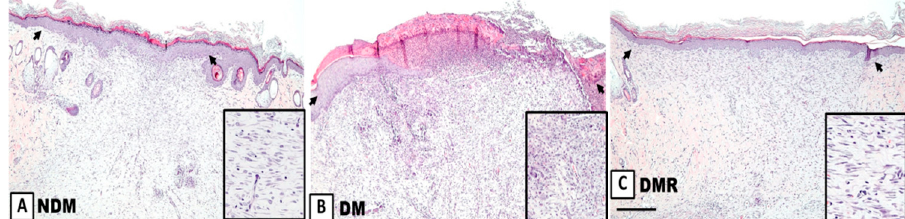
Figure 4. Representative images of wound tissue ( A )–( C ) on day 21 (H&E staining). The arrow indicates the width of re-epithelialization. The enlarged image shows the presence of inflammatory cells. Scale bar: 300 μ m.